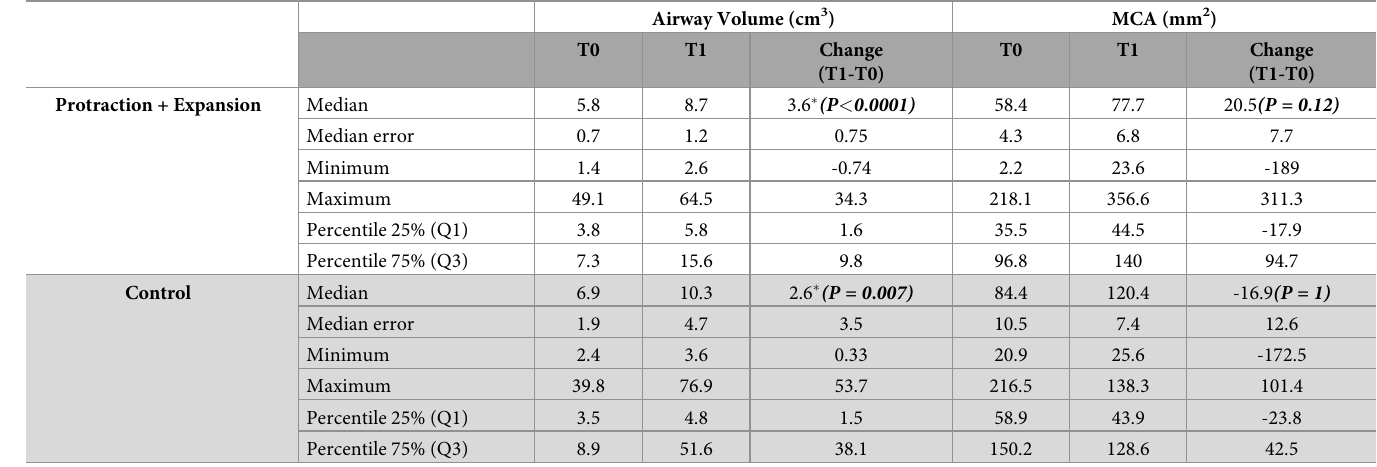
Table 2. Statistics of oropharyngeal airway volume and MCA before (T0) and after (T1) treatment in both